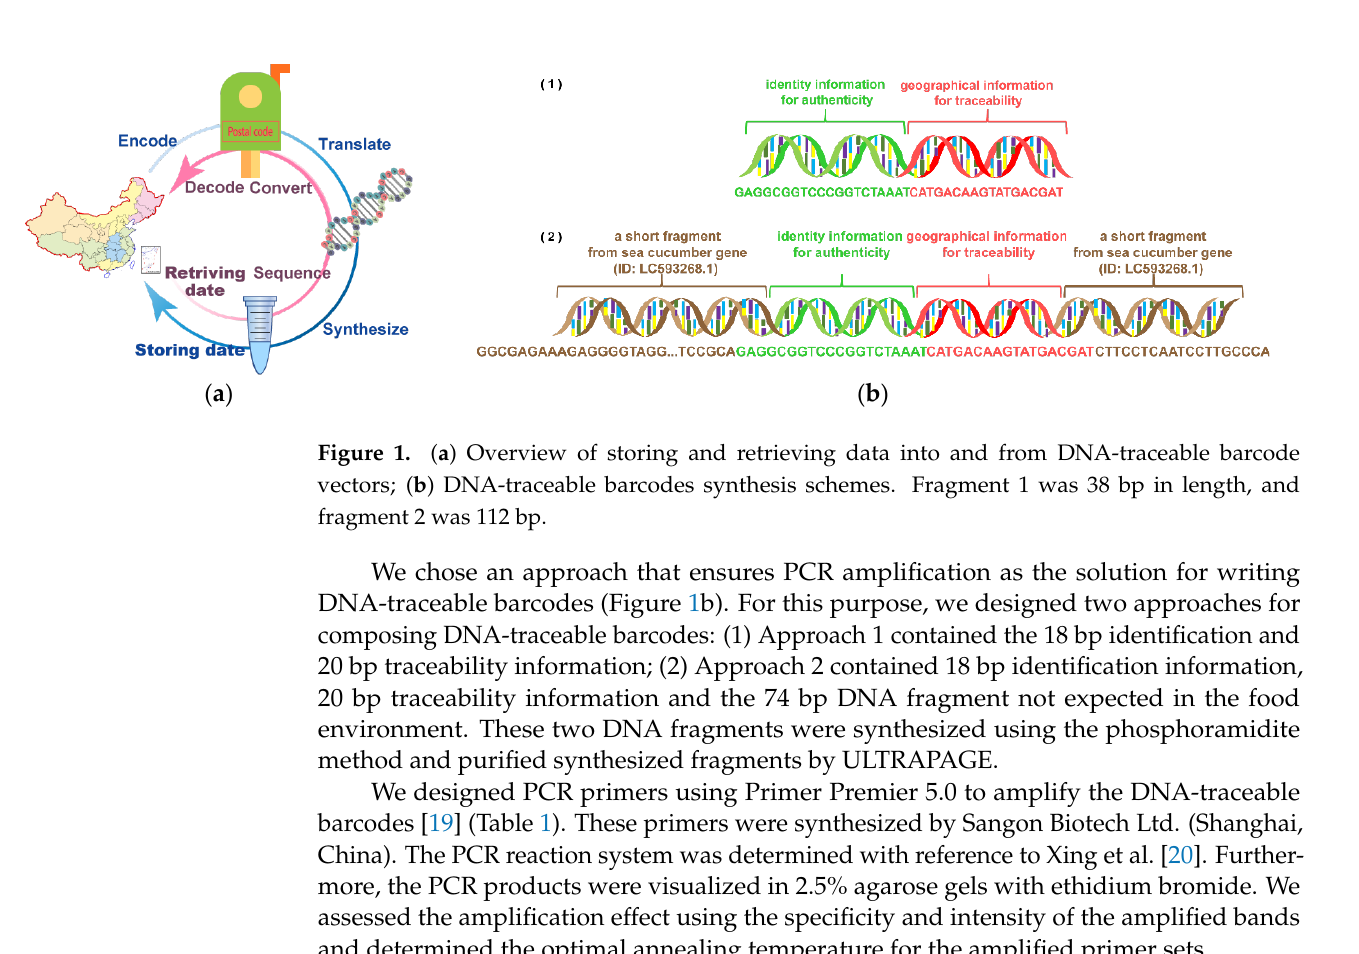
Table 1. DNA-traceable barcode amplification and identification solutions.